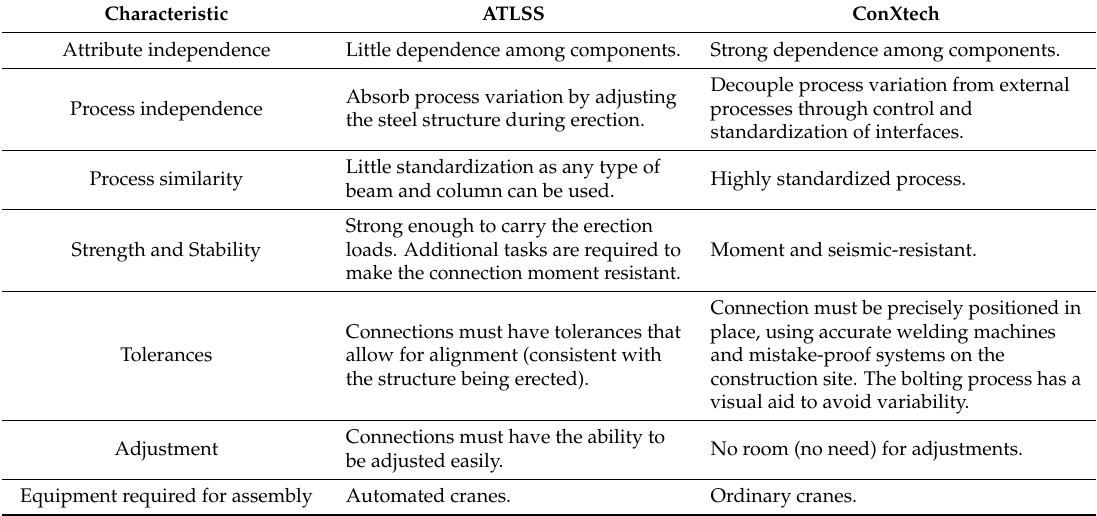
Table 3. Comparison between ATLSS and ConXtech